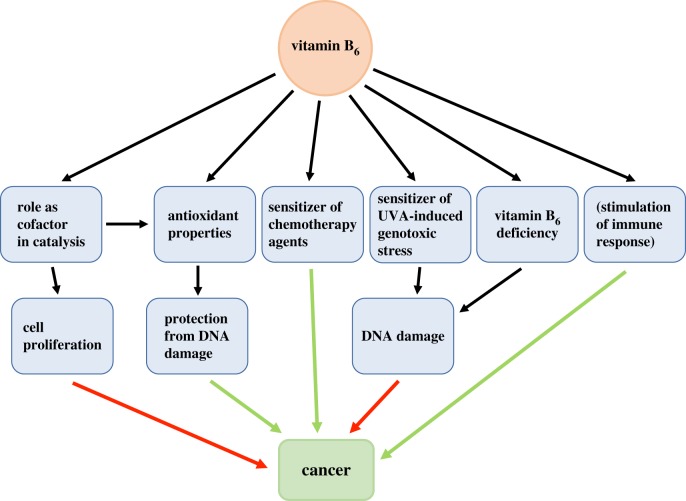
Relationships between vitamin B6 and cancer. In the scheme, green arrows represent a protective effect against cancer, whereas red arrows indicate a promoting cancer effect.